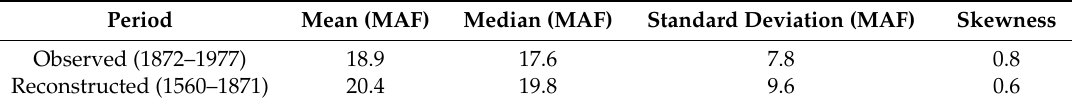
Figure 7. Reconstructed streamflow using the ANN model.